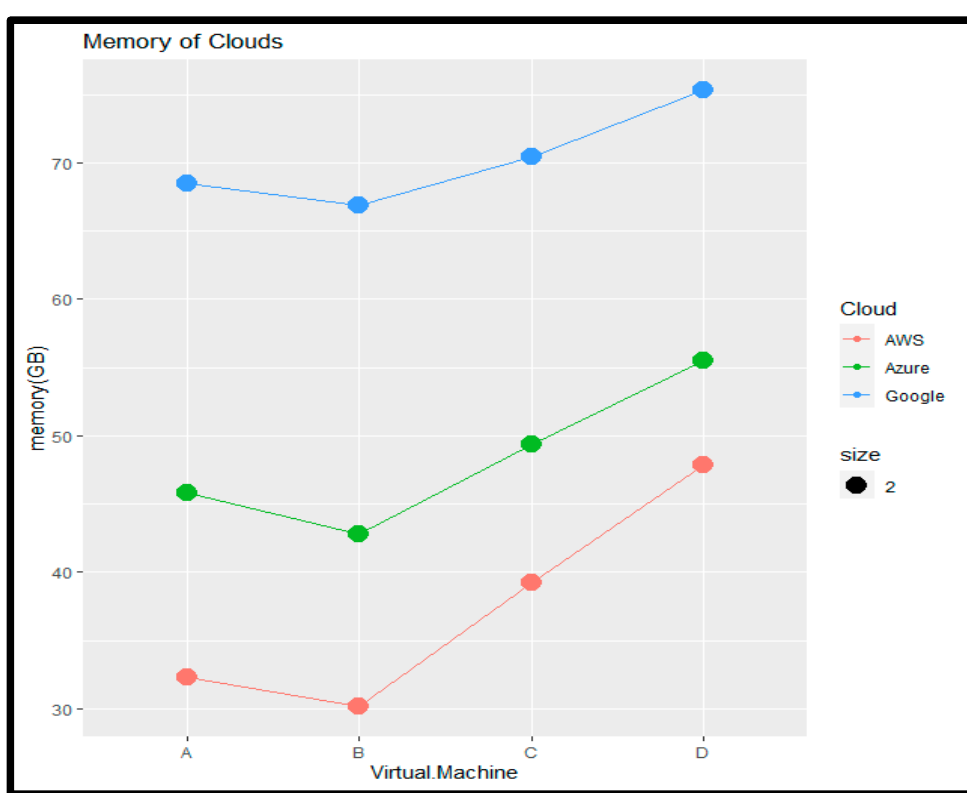
Figure 9. Distance (K) for different VMs on clouds .